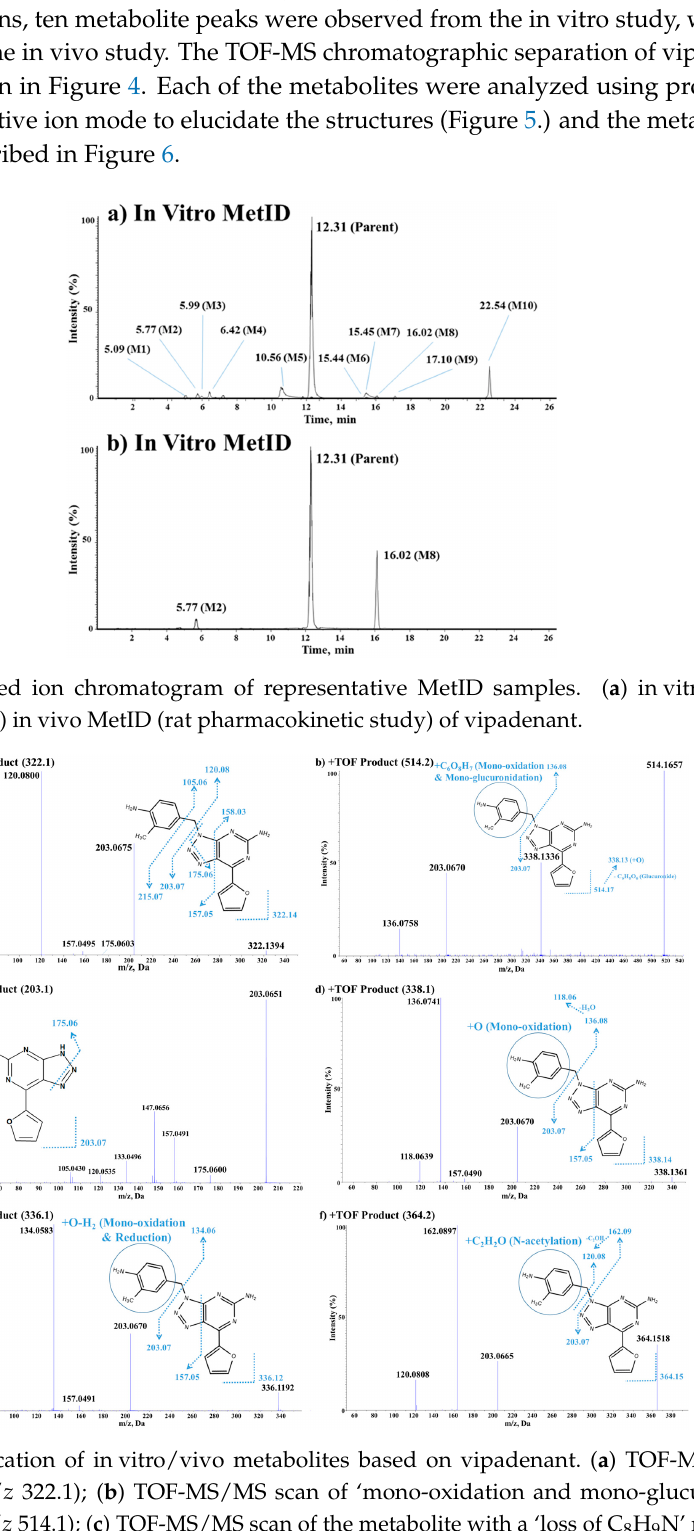
Figure 6. Metabolic pathways of vipadenant in vitro/vivo.